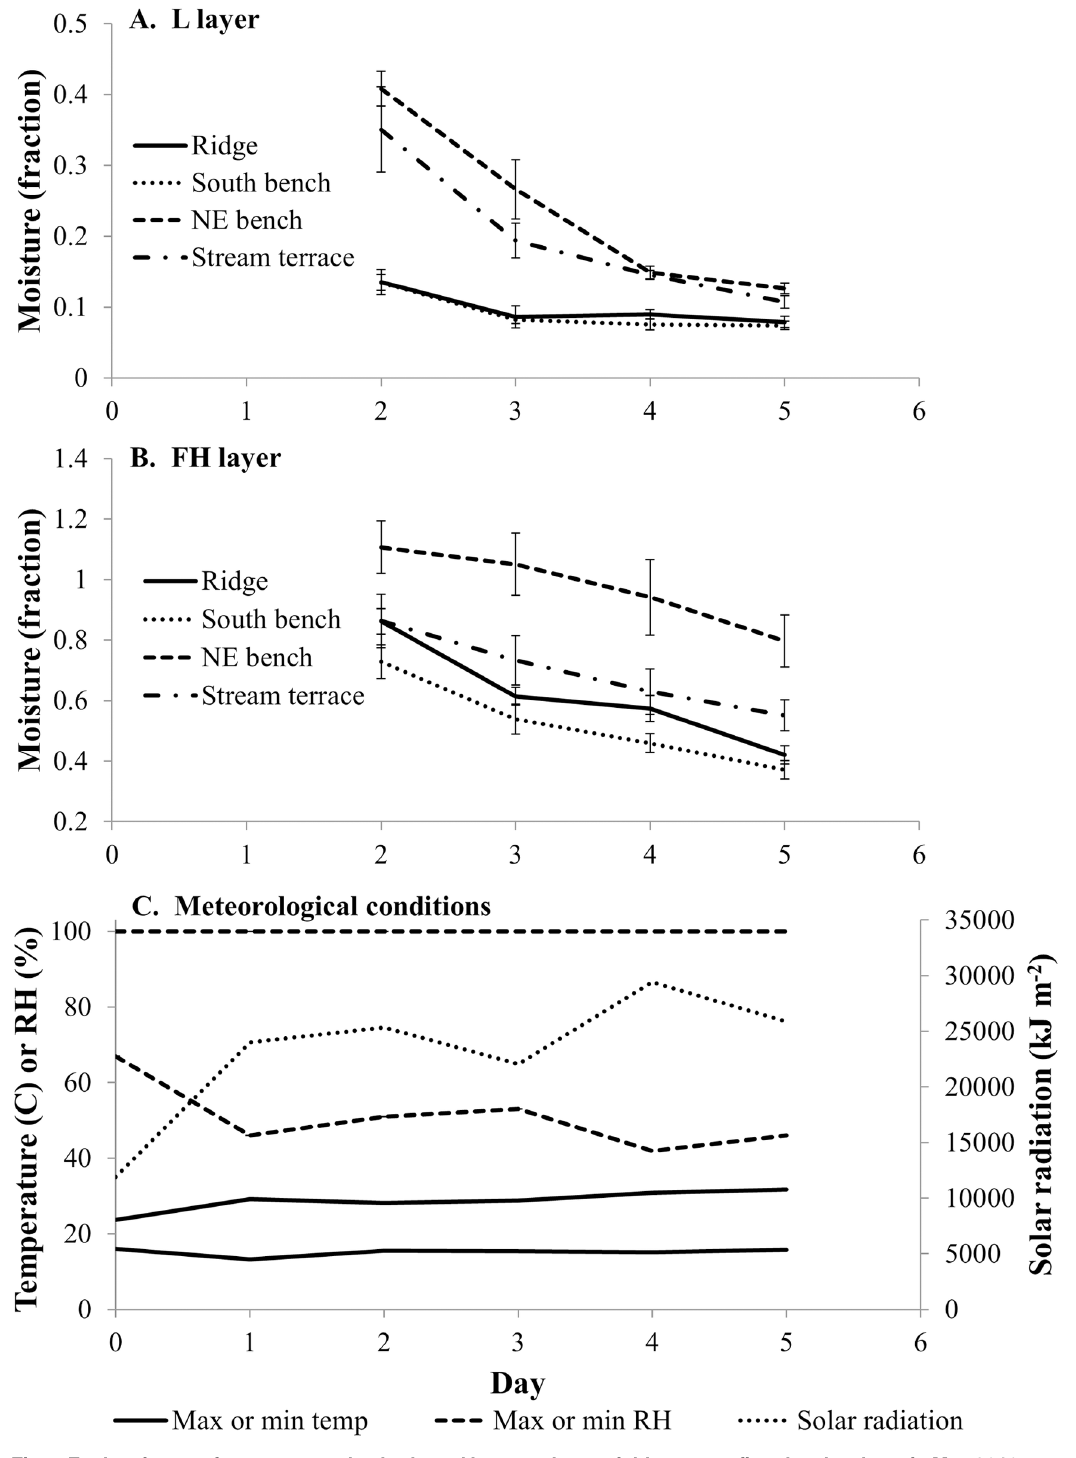
Fig 7. Fuel moisture of common garden beds and key weather variables over a five-day dry-down in May 2010. Effects of topographic position and day were significant and are shown while litter source effects were not significant and are not included (Table 4). Data are separated between the L and FH layers (panels A and B, respectively). Standard errors are included. Note that the scale for the FH-layer plot has a larger range because of greater moisture contents. Weather variables (C) were measured at the VFEF headquarters (see Fig 2 for location). A wetting rainfall occurred early on 22 May 2010 (day